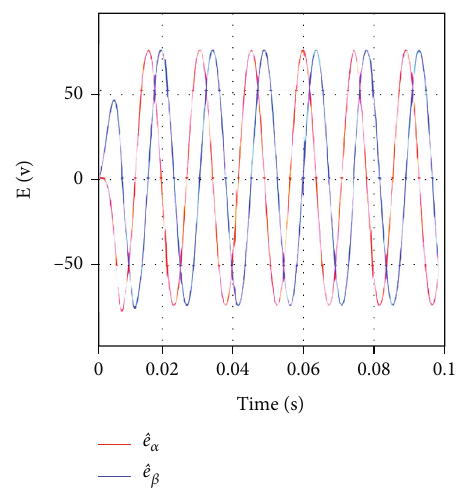
Figure 13: BEMF waveforms using 2021 LO.